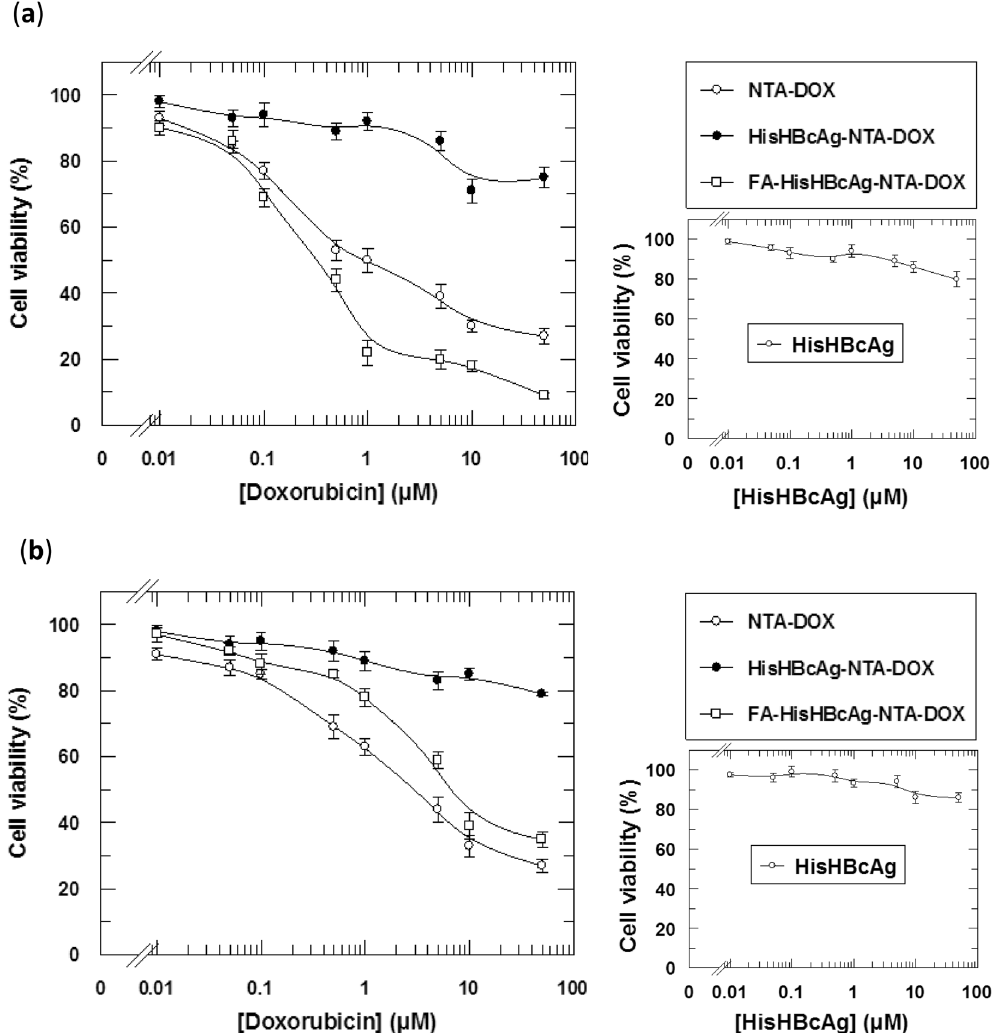
covalently with folic acid (FA) and non-covalently with NTA-DOX (FA-HisHBcAg-NTA-DOX) were more efficient in inhibiting the growth of OVCAR-3 cells compared to that of other formulations. On the other hand, this formulation (FA-HisHBcAg-NTA-DOX) was less toxic to normal 3T3 cells, resulted in a conferred protection of the normal cells from DOX. The HisHBcAg nanoparticles (HisHBcAg) were not toxic to both normal and cancer cells as shown in the small graphs on the right. Data represent mean ± SD of triplicate